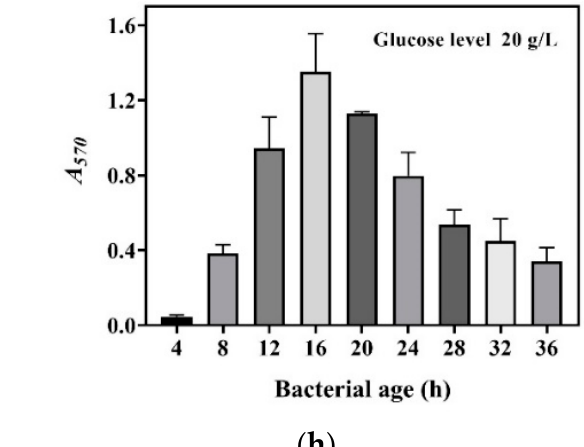
Figure 2. Effects of glucose level and bacterial age on whole-cell catalysis. The GABA fermentations were individually conducted in fermentation media containing 0 ( a ), 10.0 ( b ), 20.0 ( c ), 30.0 ( d ), 40.0 ( e ), and 50.0 g/L ( f ) of glucose. Cells were recovered from each fermentation broth at 4, 8, 12, 16, 20, 24, 28, 32, and 36 h and used to conduct 16 h whole-cell catalysis. A GABA production-time profile was created for each whole-cell system. ( g ) Effects of glucose level on whole-cell catalytic ability (the bacterial age was 16 h). ( h ) Effects of bacterial age on whole-cell catalytic ability (cells were cultivated in the fermentation medium with 20.0 g/L glucose). Bacterial age means GABA fermentation time of L. brevis CD0817, shown in the blank area in the upper left corner of subfigures ( a – f ). The relative content of GABA was determined using the SINACS method, and it is expressed as A 570 ( n = 3). A 570 , absorbance at 570 nm; SINACS: sensitivity intensified ninhydrin-amino acid chromogenic system.